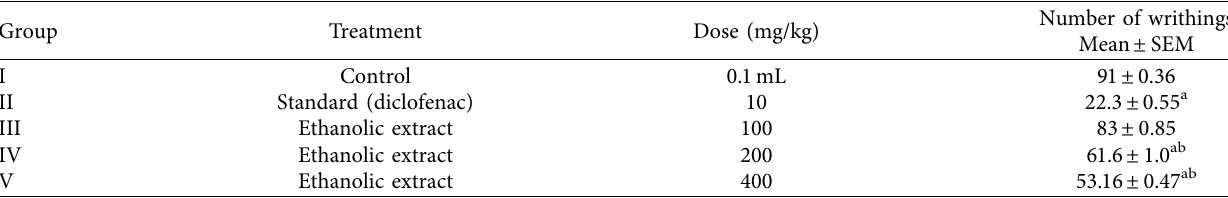
Table 6: Efect of ethanolic extract of Artocarpus hirsutus Lam by acetic acid induced writhing method. Group